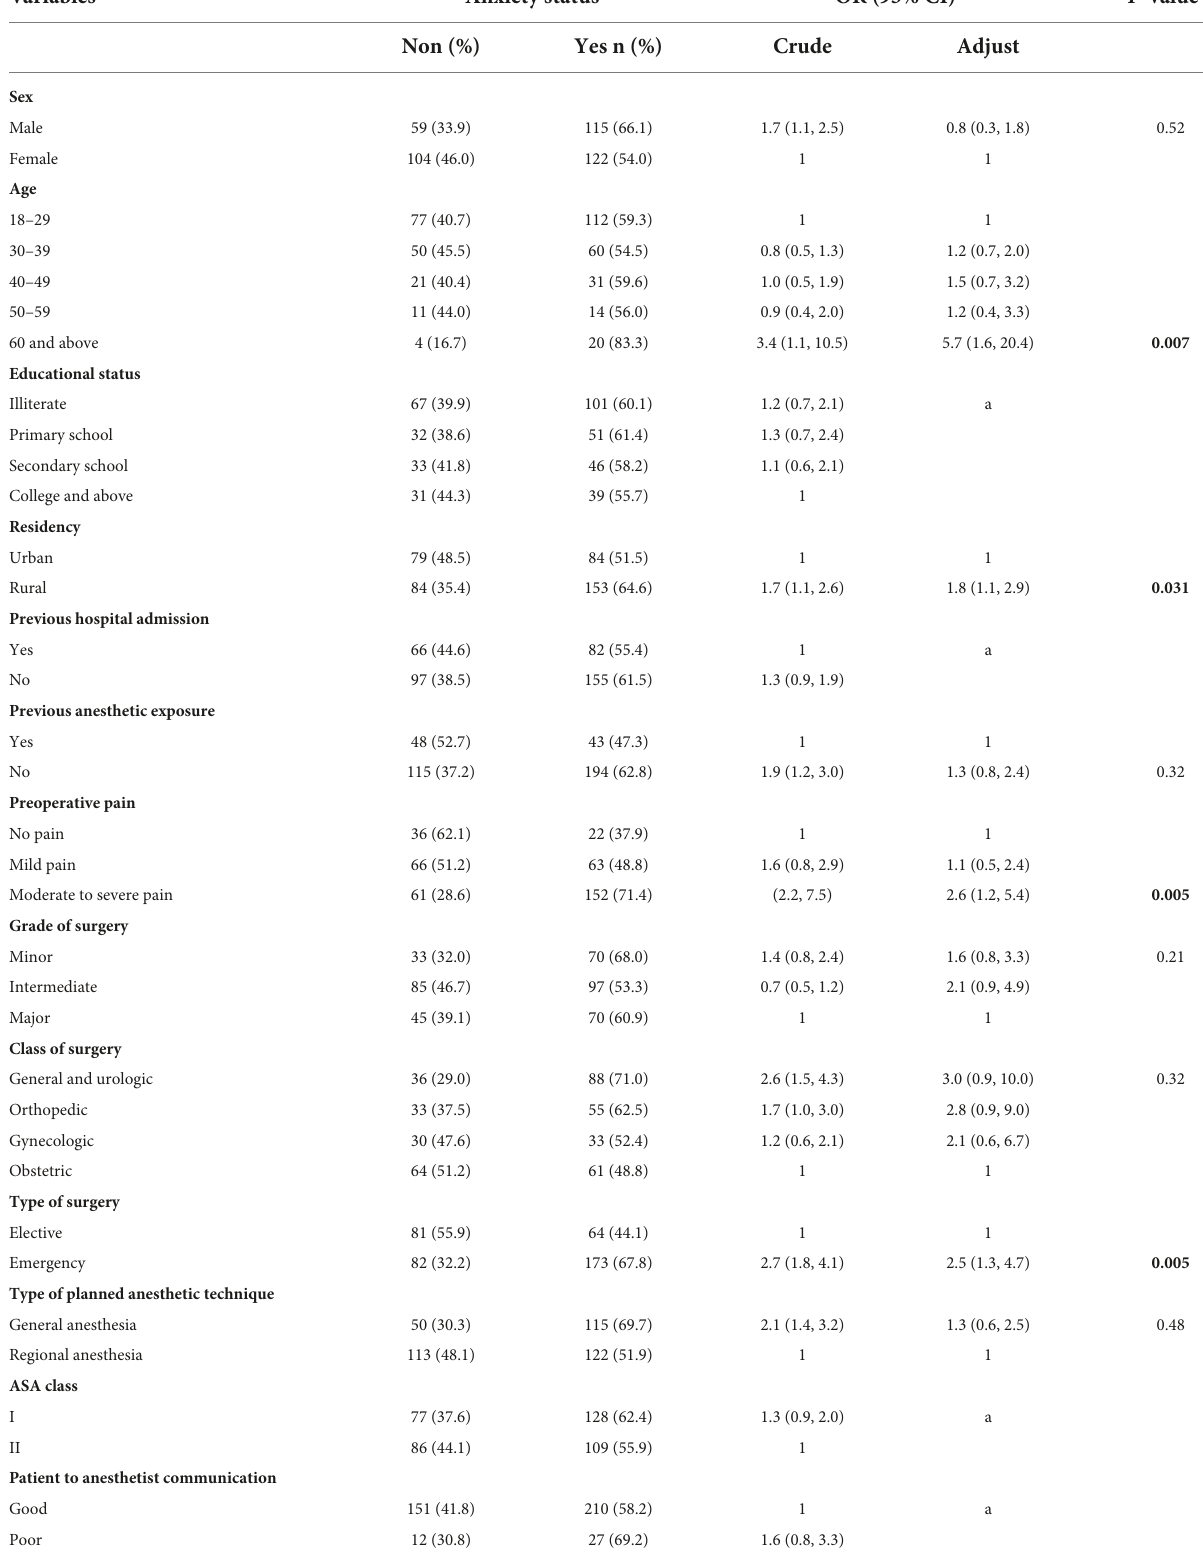
TABLE 3 Binary logistic regression; factors associated with preoperative anxiety among surgical patients, N = 400.